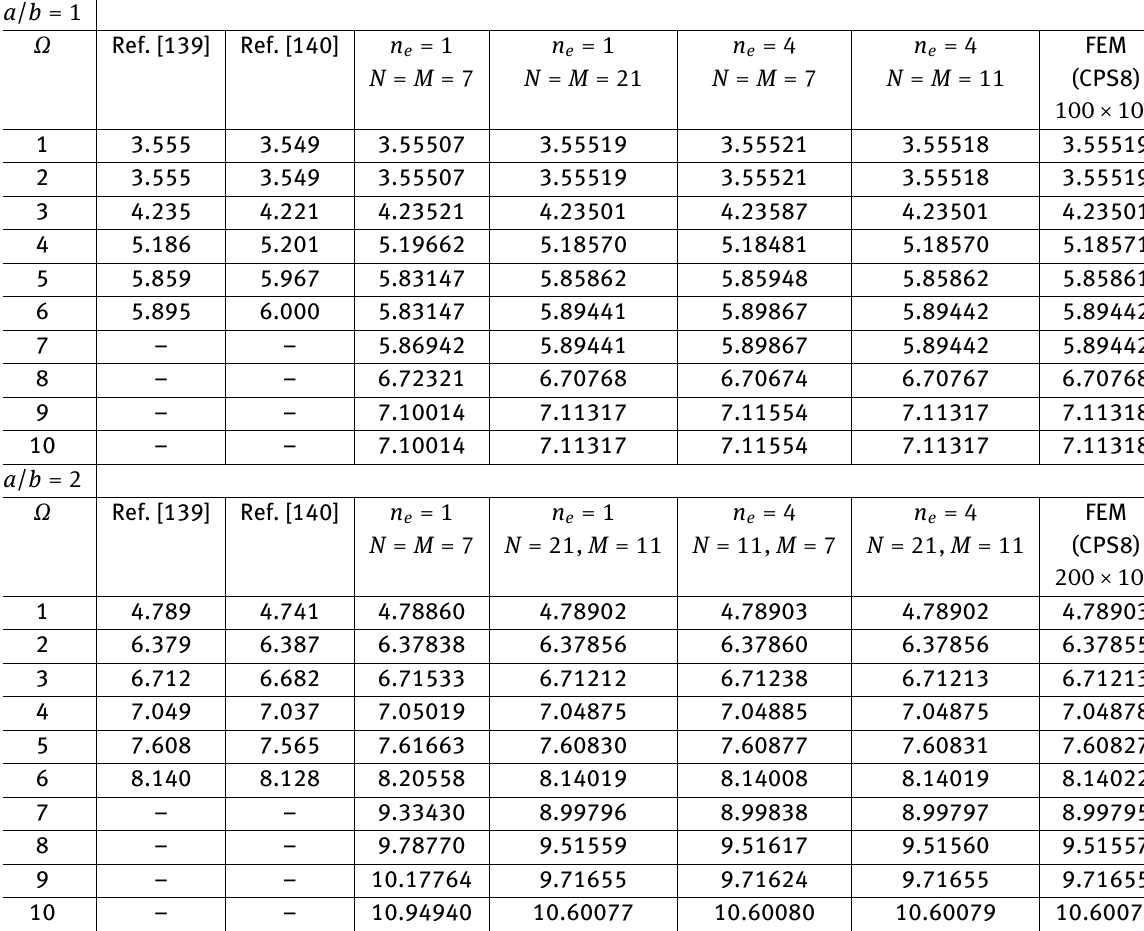
Table 1: First ten dimensionless frequencies for C-C-C-C isotropic in-plane square and rectangular plates using different